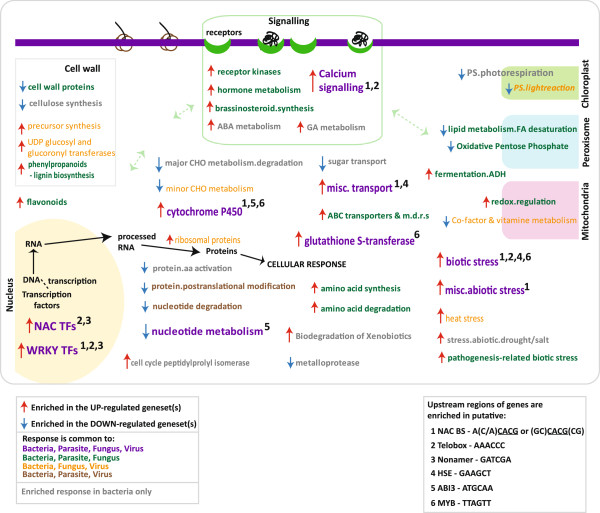
Transcriptomic signatures of biotic stress responses. Pageman analysis was carried out revealing the over-represented functional categories across the differentially expressed genes following for bacterial, parasite, fungal and viral infections. When functional categories were over-represented in the same (up/down-regulated) genesets, across 3 or more biotic stresses, these functional categories are shown with the common response (up/down) indicated by a red/blue arrow, respectively. In addition to these, the functional categories seen only to be responsive under bacterial infection are indicated in grey. Also, over-represented putative motifs (listed in Table 2) for the genes in each of the overlapping, over-represented functional categories are shown, with specific motif(s) indicated by a number(s).